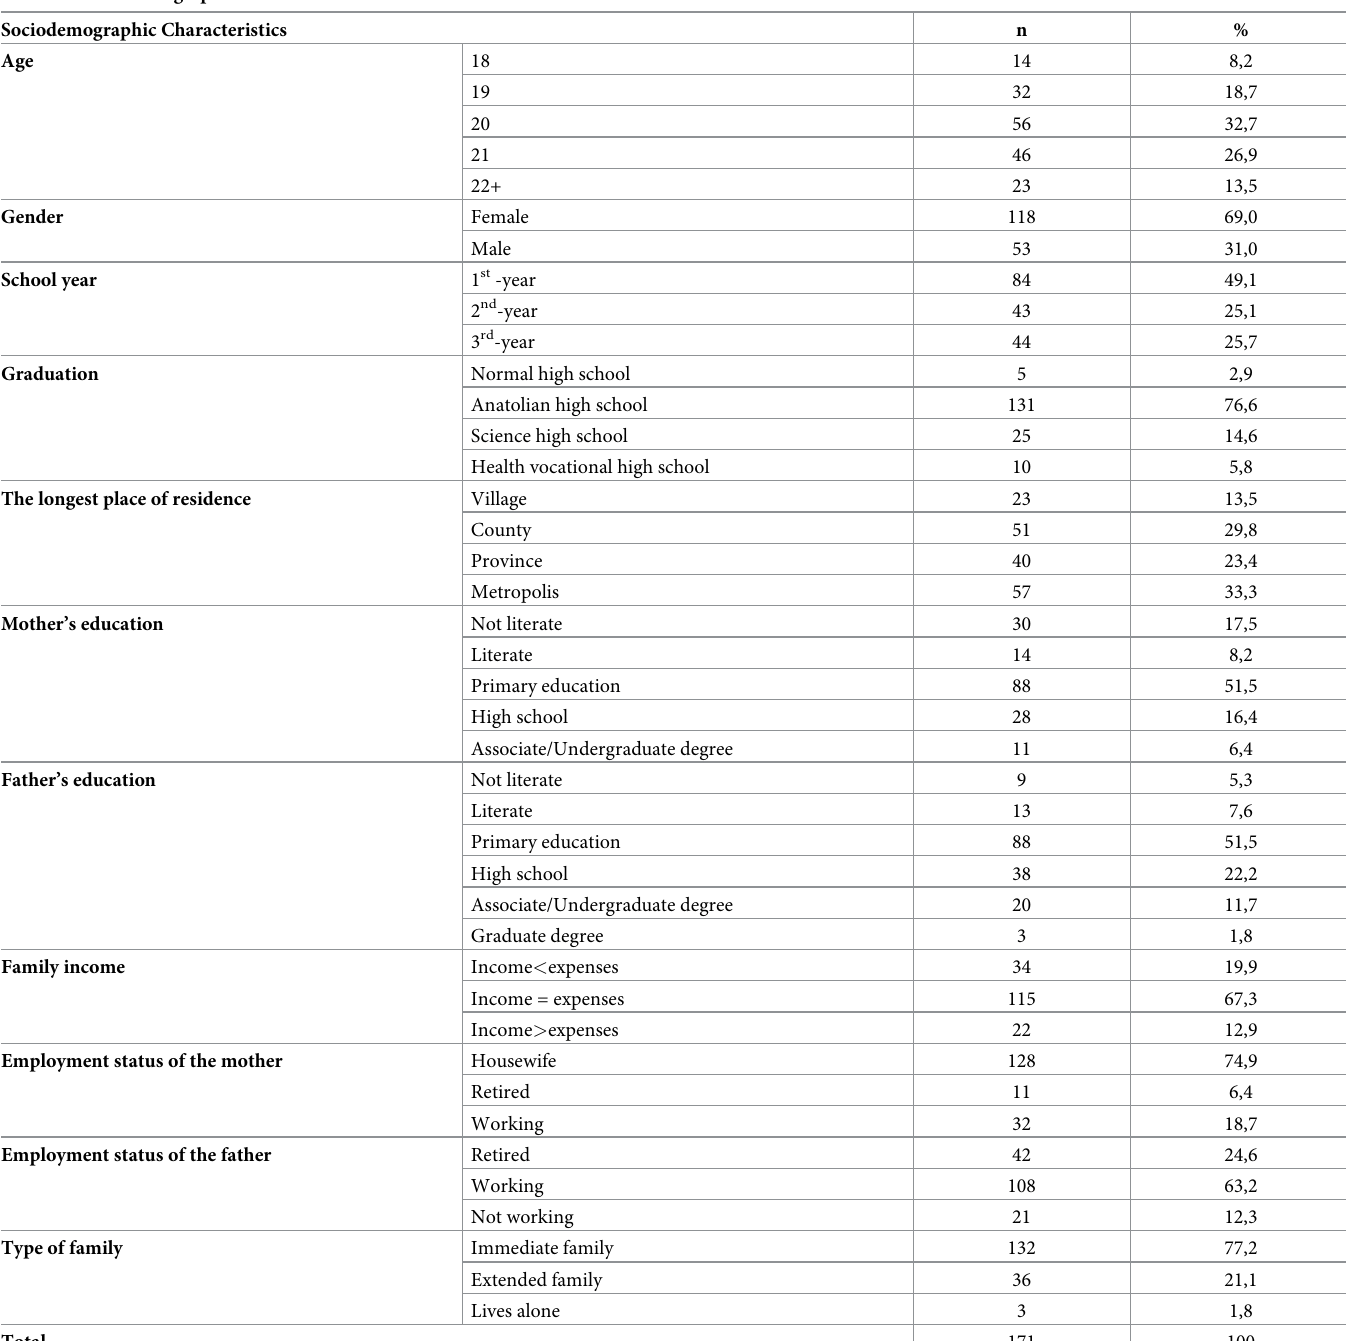
Table 1. Socio-demographic characteristics of the students. Sociodemographic